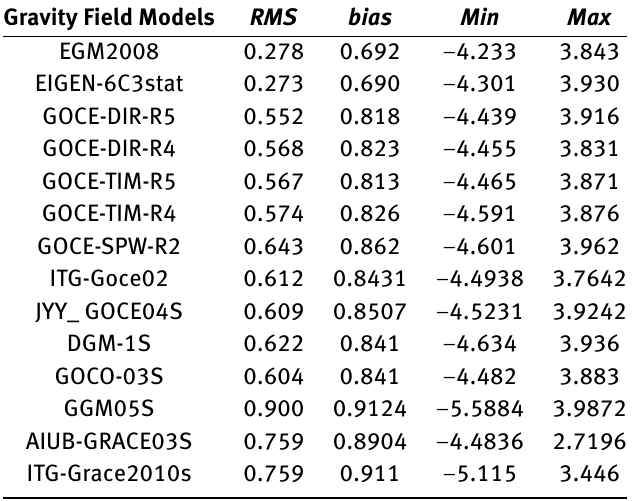
Table 2: Statistics of the comparison between GPS/levelling data and geoid heights based on global gravity models after the estimation of a constant bias. Data refer to a set of 3293 data points over the Hellenic region. Maximum degree of its model is considered. Unit is meters.